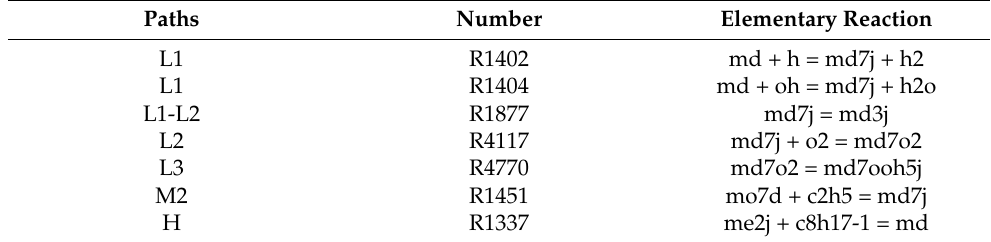
Table 4. Key positions of high-temperature transformation in MD and related elementary reaction table. Paths